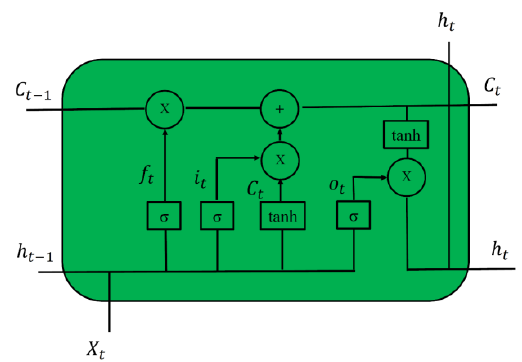
Figure 2. The memory block of long short-term memory (LSTM) neural networks.